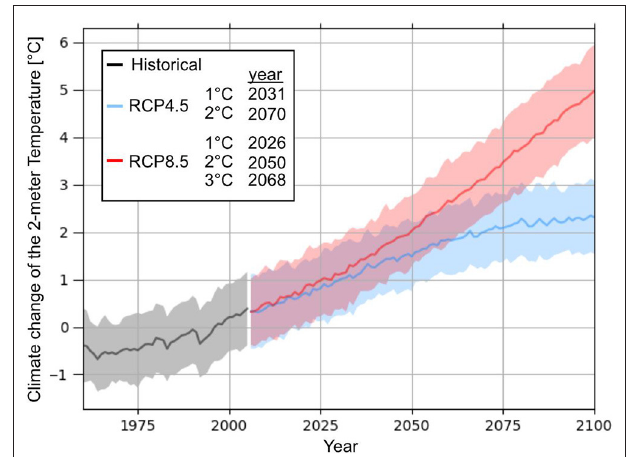
FIGURE 7 | Global average of the ensemble mean of the 2-m temperature from the CMIP5 model used as driving data for this study. The black, blue, and red lines are the historical, RCP4.5 and RCP8.5, respectively. The shadow represents the standard deviation of the model ensemble. The years in the legend represent the year where the i ◦ C was crossed by the global ensemble